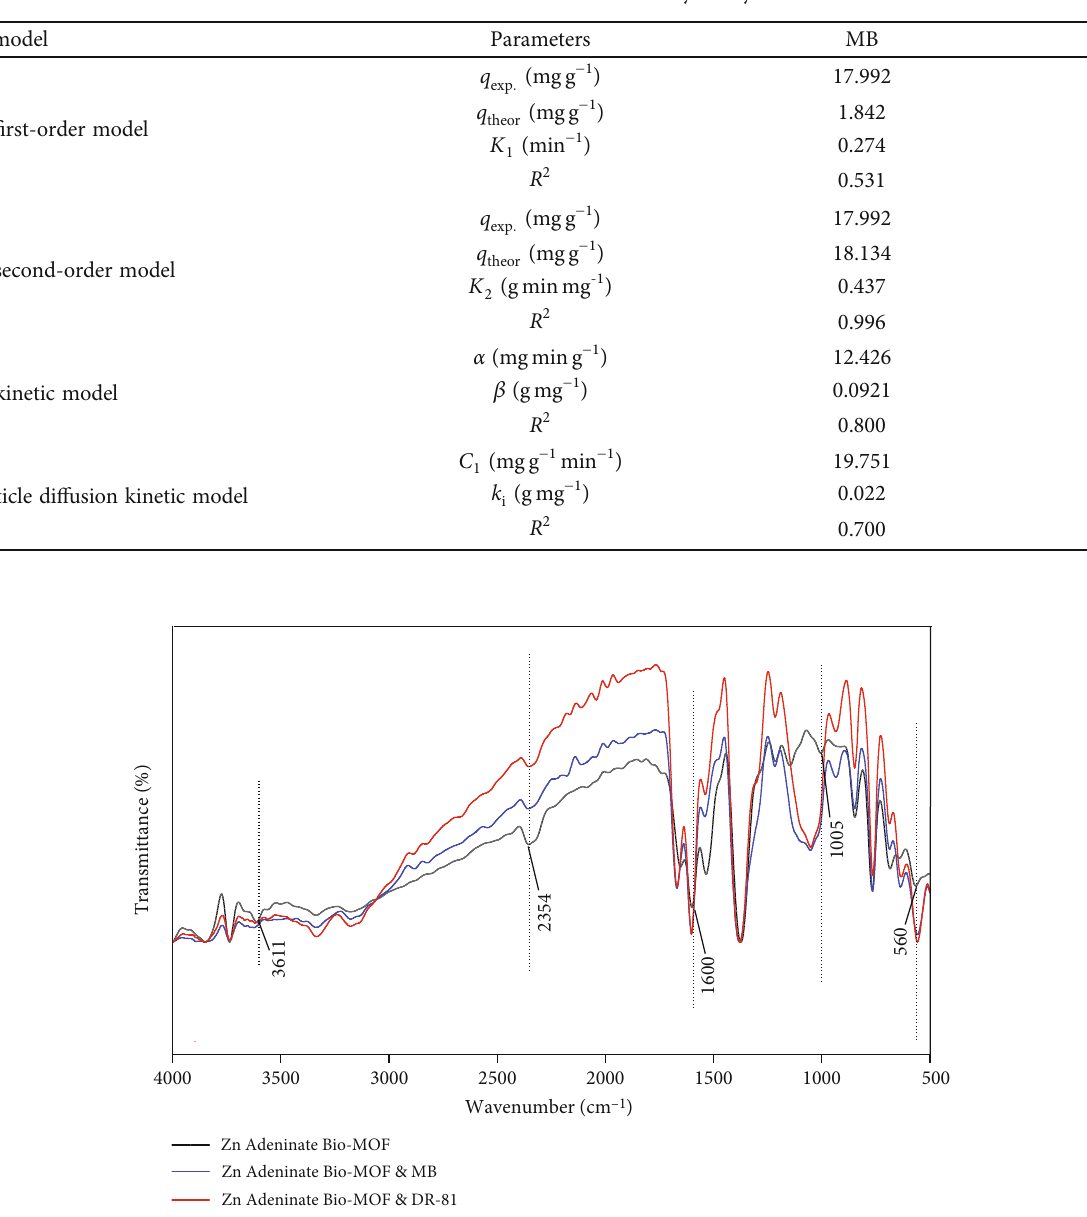
Table 4: Parameters of the kinetic models for MB and DR-81 removal by the synthesized Zn-adeninate bio-MOF.